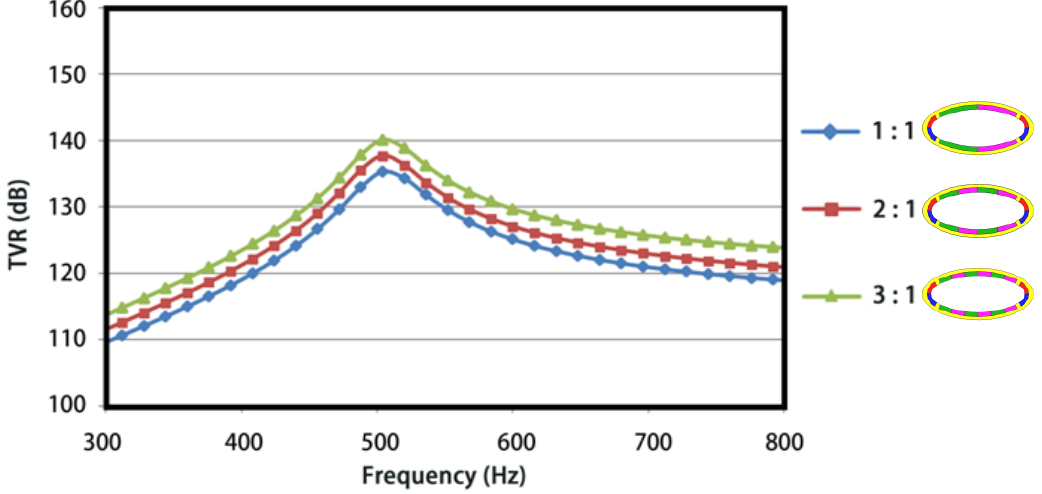
Figure 14. Influence of the ratios of ceramics’ number in long and short arc stacks on the TVR.